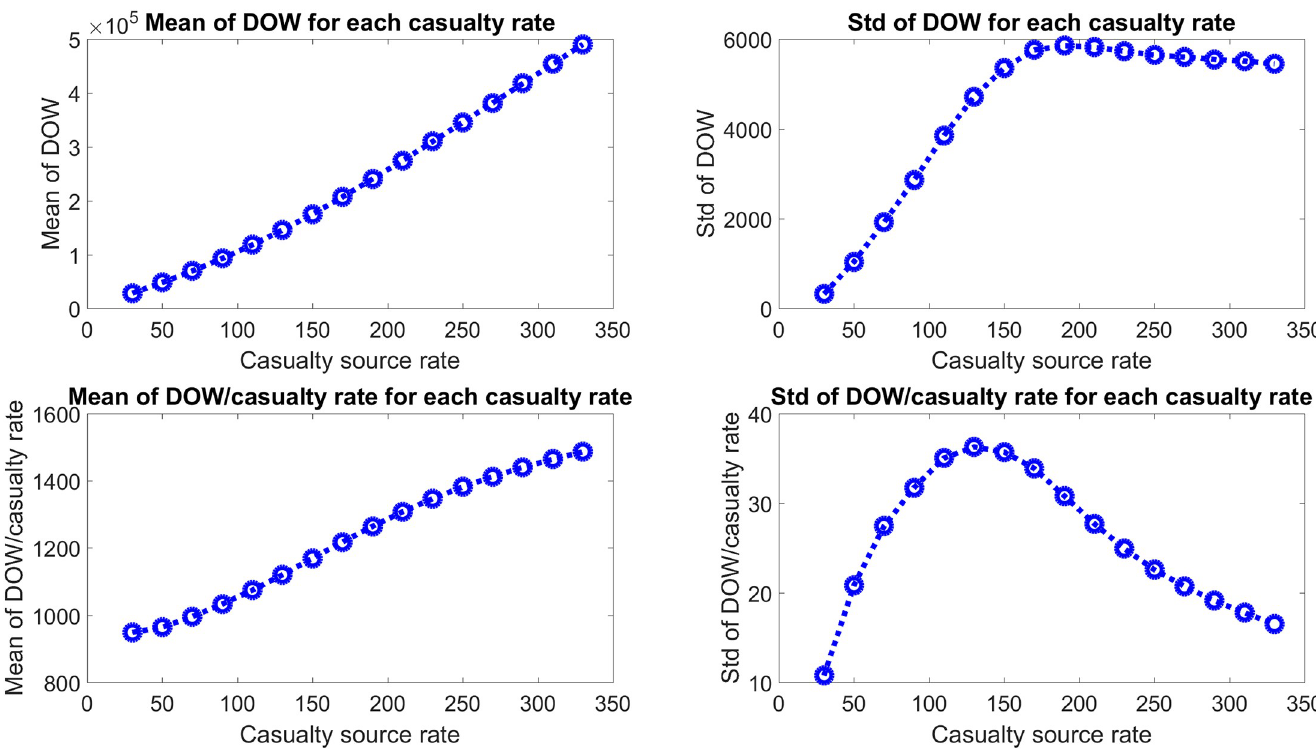
Fig 4. Mean and standard deviation of total Dead Of Wounds (DOW) for each casualty source rate. The top row shows the mean and standard deviation of DOW, and shows that the mean DOW increases superlinearly with casualty source rate, while the standard deviation reaches a maximum and levels out around a casualty source rate of around 175. To show the deviation from a linear increase, the bottom row shows the mean and standard deviation divided by the casualty source rate. This shows a sigmoidal shape to the mean plot and a clear peak to the standard deviation plot at around 130 casualties/source/day.